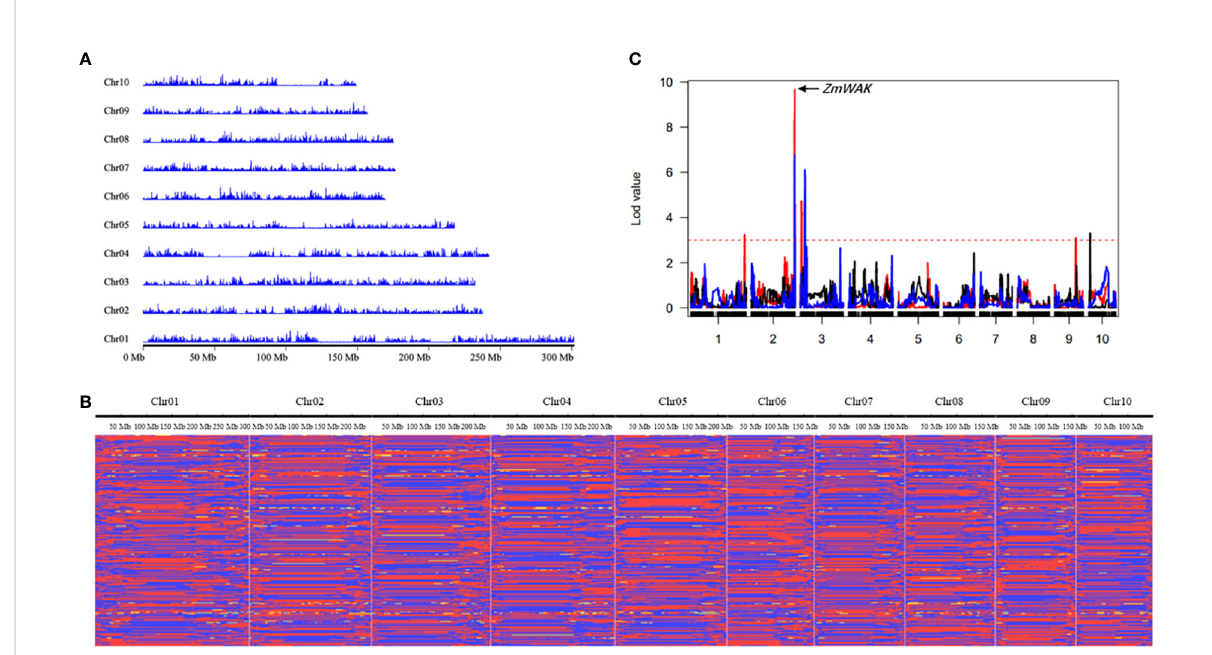
FIGURE 3 Genetic linkage map construction with bin markers. (A) SNP density distribution across the ten chromosomes. (B) Graphic genotype of 275 RILs. red, Ye3189 genotype; blue, Ji846 genotype; yellow, heterozygous genotypes. (C) Mapping of 2.09 and 3.04, which control maize head smut, in the RIL population. The curves with different colors represent the QTL regions according to the con fi dence intervals for linkage mapping under the three environments, respectively. Red, 2007 Harbin; black, 2008 Harbin; blue, 2009 Harbin; The x-axis indicates genetic positions across the maize genome in Mb. The y-axis indicates the LOD score of the detected QTL. The red dashed lines represent the LOD threshold.